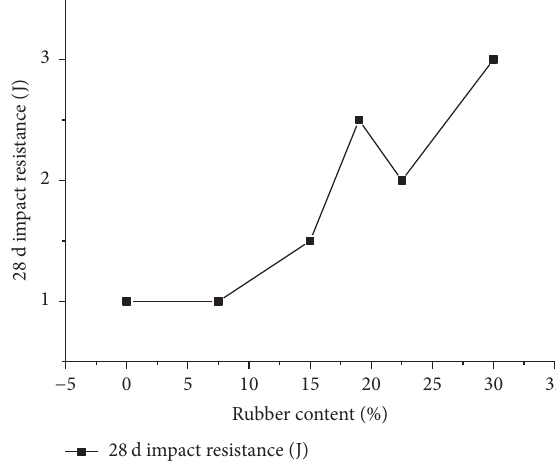
Figure 8: 28 d the impact resistance of cement mortar with different amount of 60-mesh rubber particles.